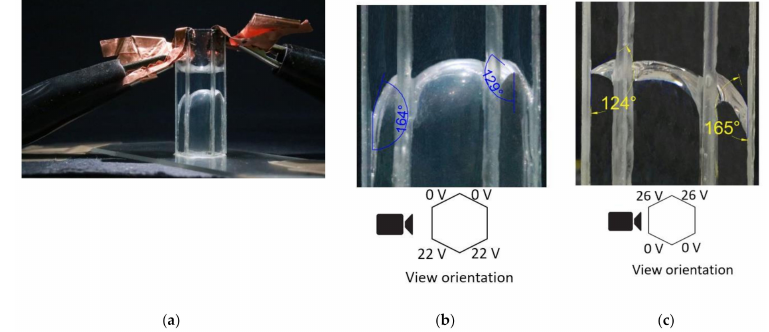
Figure 11. Liquid-liquid interface angle changes on the sidewalls. ( a ) experimental setup showing the contact pads used to supply voltage to the electrodes, ( b ) 22 V on the two adjacent electrode faces on the cell’s right side, ( c ) 26 V on the two adjacent electrode faces on the cell’s left